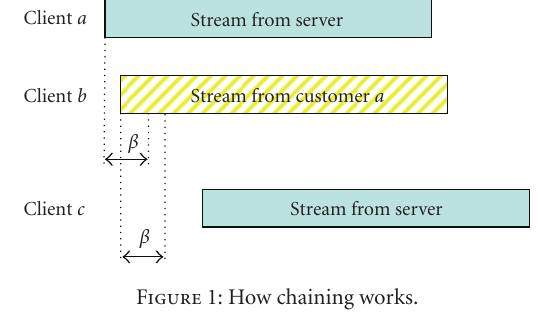
Figure 1: How chaining works.